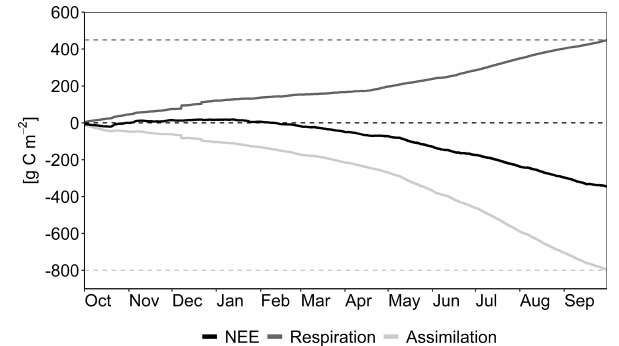
Figure 11. Energy and NEE fluxes from the maritime pine stands during a rainless period towards the end of the first post-fire hydro- logical year, from 4 to 9 September 2018.